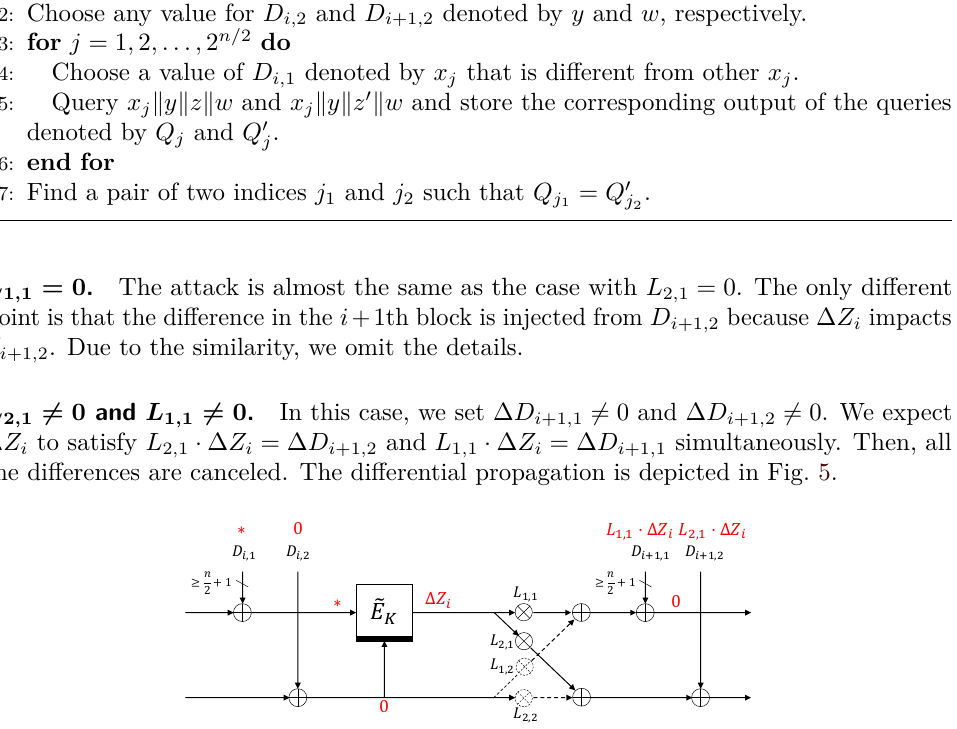
Figure 5: Differential Propagation for Case 1 with L 2 , 1 6 = 0 ∧ L 1 , 1 6 =